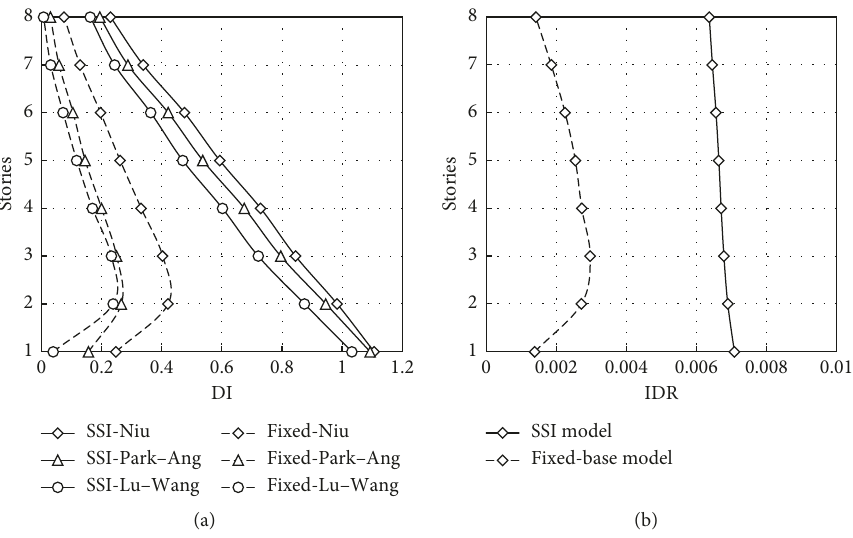
Figure 6: Distribution of damage at PGA of 0.2g with DPDMs (a) and the MIDR